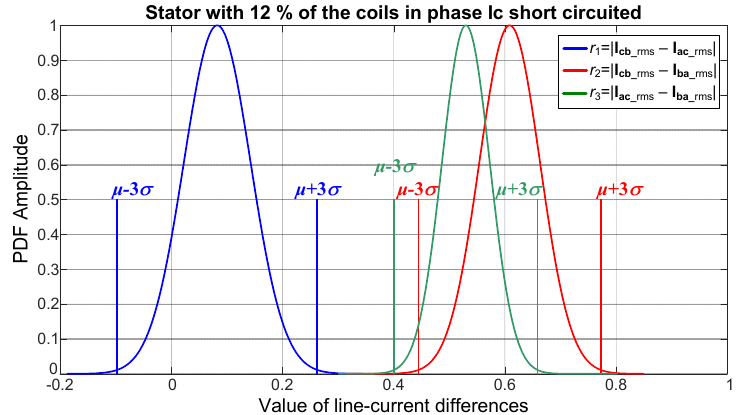
Figure 15. PDF for the arithmetic differences r 1 , r 2 , and r 3 from a motor with 12% of the coils in its